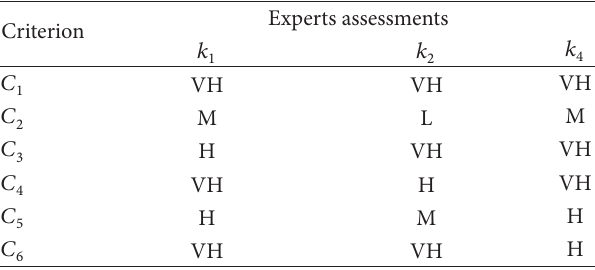
Table 6: The performance rating of the 6 criteria.